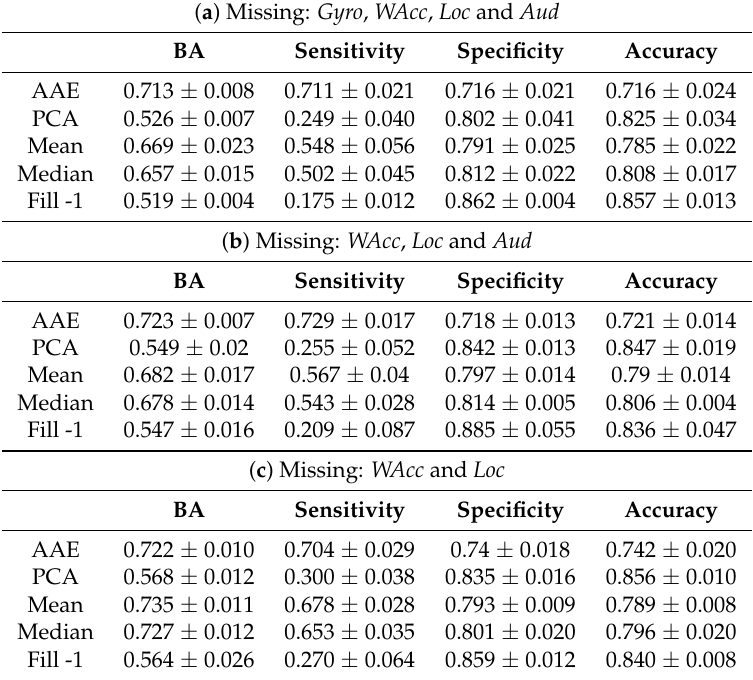
Table 2. Classification results for 5-folds cross-validation with different missing modalities that are restored with a specific method. The reported metrics are averaged over 51 labels and BA stands for balanced accuracy.